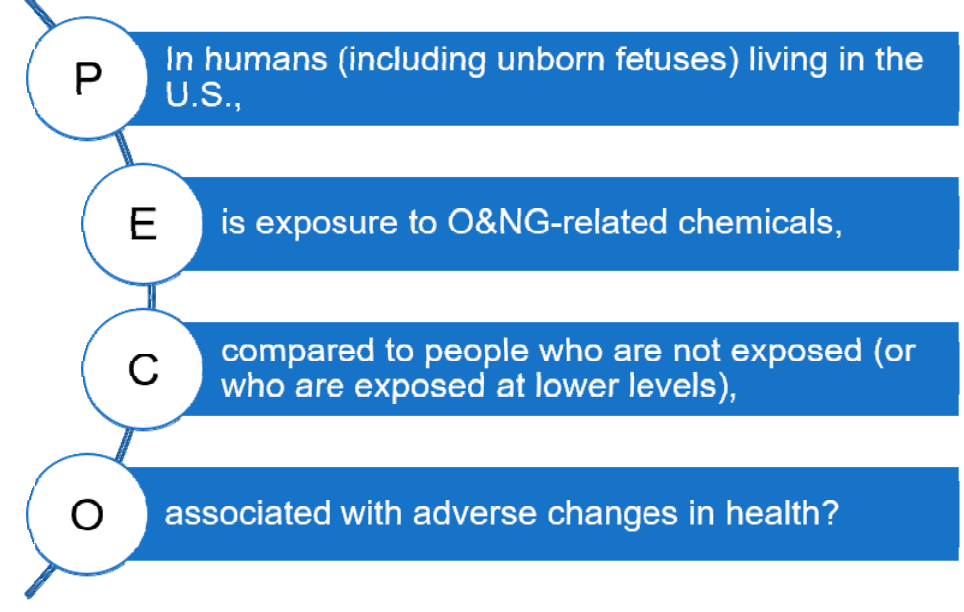
Figure 2. Populations, exposures, comparators, and outcomes (PECO) statement .